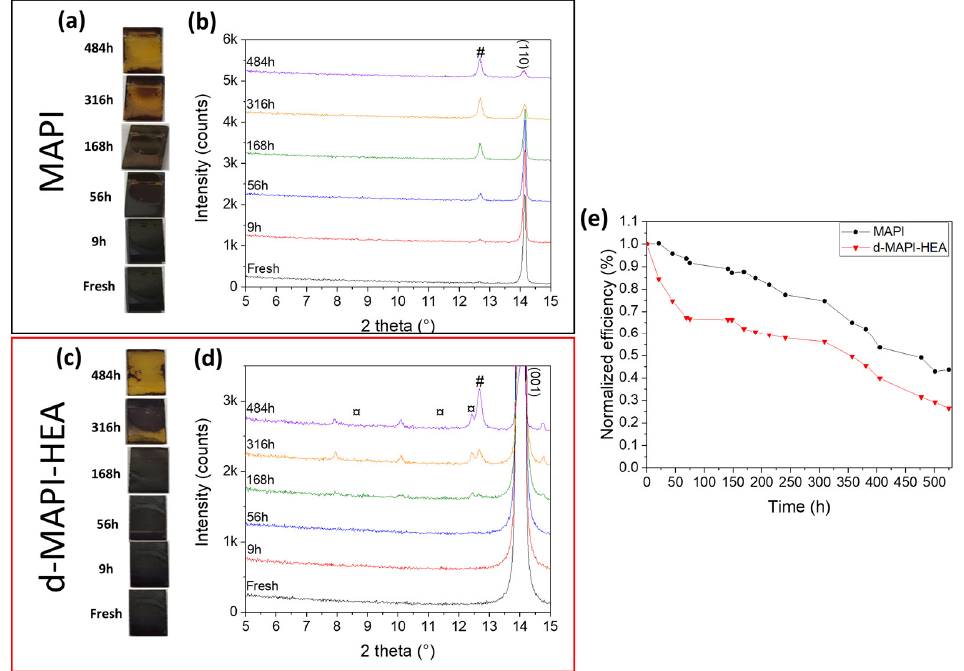
Figure 4. ( a ) Pictures of MAPI unencapsulated films upon aging. ( b ) XRD patterns upon the stability test of MAPI. ( c ) Pictures and ( d ) XRD patterns zoomed between 5° and 15° from the stability test of the unencapsulated d-MAPI-HEA films. FTO peaks are indicated by the ¤ symbol. # Indicates PbI 2 . ¤ symbol indicates unknown phases. ( e ) Evolution of normalized efficiency of unencapsulated MAPI and d-MAPI-HEA devices as a function of aging time. Storage upon aging tests was made in air under ambient conditions (50–70% RH; T° = 15–20 °C) and ambient light.